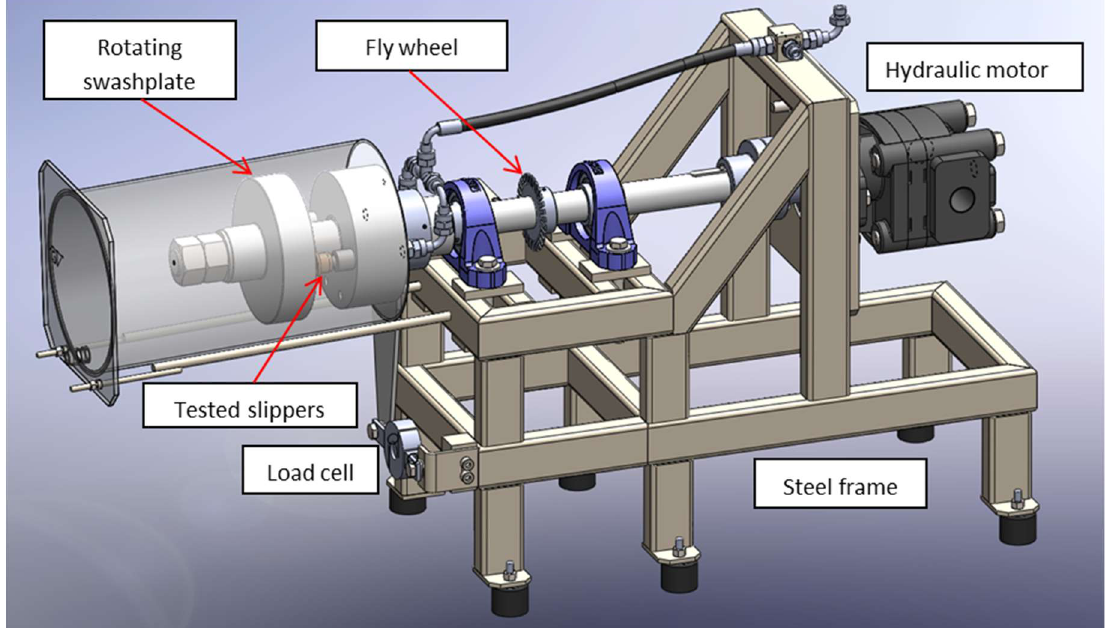
Figure 3. Test rig for the assessment of friction on brass slippers in hydrodynamic lubrication regime.